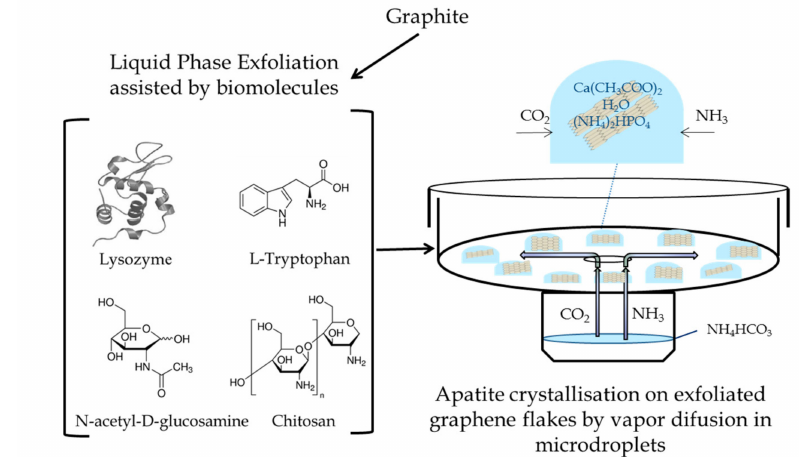
Figure 1. Schema showing the preparation of graphene flakes by sonication-assisted liquid-phase exfoliation of graphite in the presence of either lysozyme (Lys), L-tryptophan (Try), N-acetyl-D-glucosamine (NAce), or chitosan (Chi), and the experiment of the mineralization of the graphene flakes with apatites implemented in a “crystallization